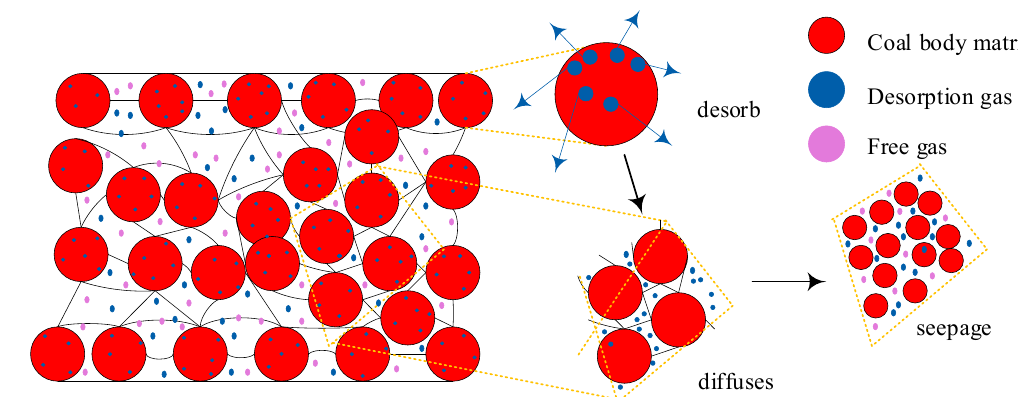
Figure 4. Coal seam gas migration process.